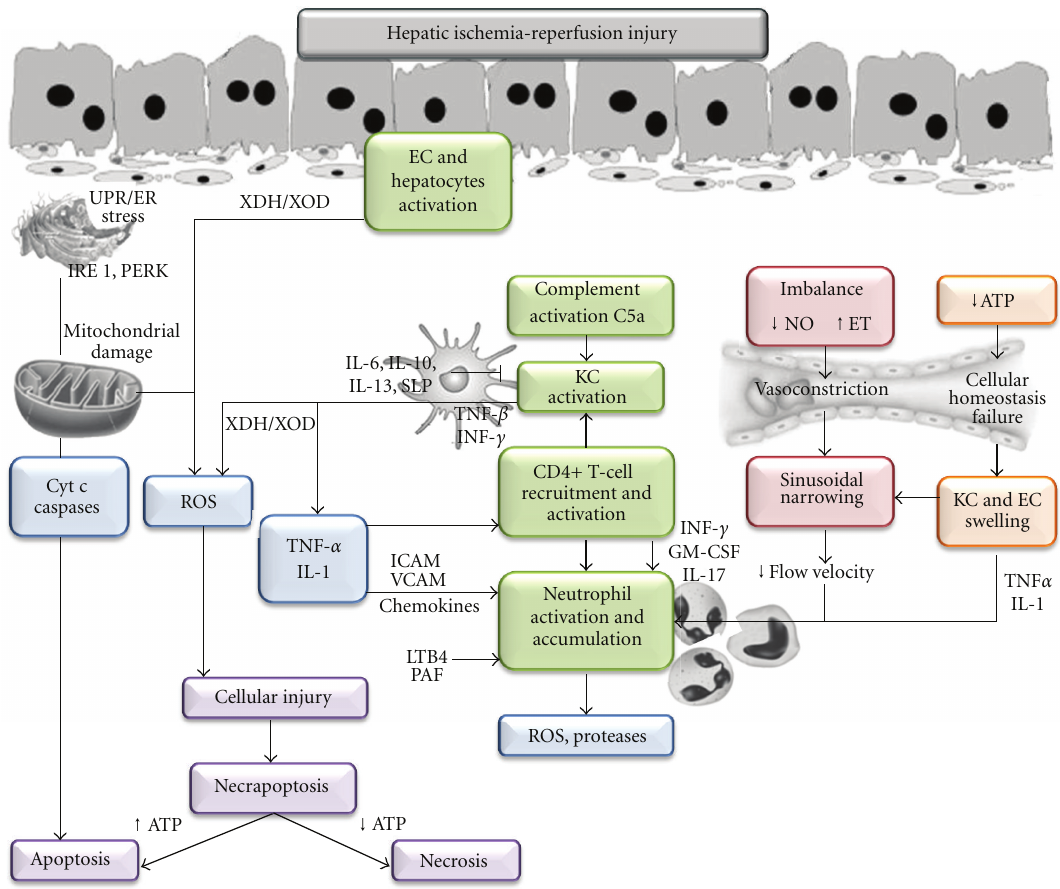
Figure 1: Mechanisms involved in hepatic ischemia-reperfusion injury. EC, endothelial cell; ET, endothelin; UPR/ER, unfolded protein response/endoplasmic reticulum; IRE1, inositol-requiring enzyme 1; PERK, PKR-like ER kinase; SLP, secretory leukocyte protease inhibitor; ICAM, intracellular cell adhesion molecule; VCAM, vascular cell adhesion molecule; GM-CSF, granulocyte-macrophage colony-stimulating factor; IL, interleukin; INF, interferon; TNF, tumor necrosis factor; PAF, platelet-activating factor; LTB4, leucotriene B4; KC, Kup ff er cell; X/XOD, xanthine/xanthine oxidase; Cyt c: cytochrome